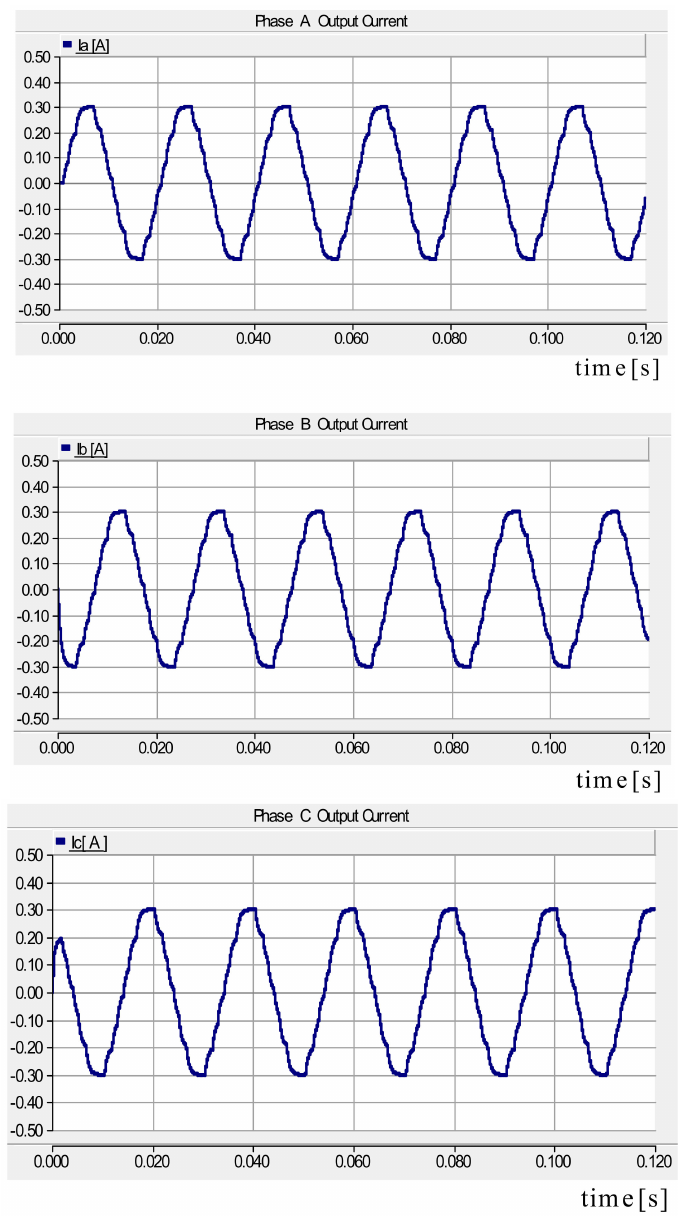
Figure 7. Phase output current